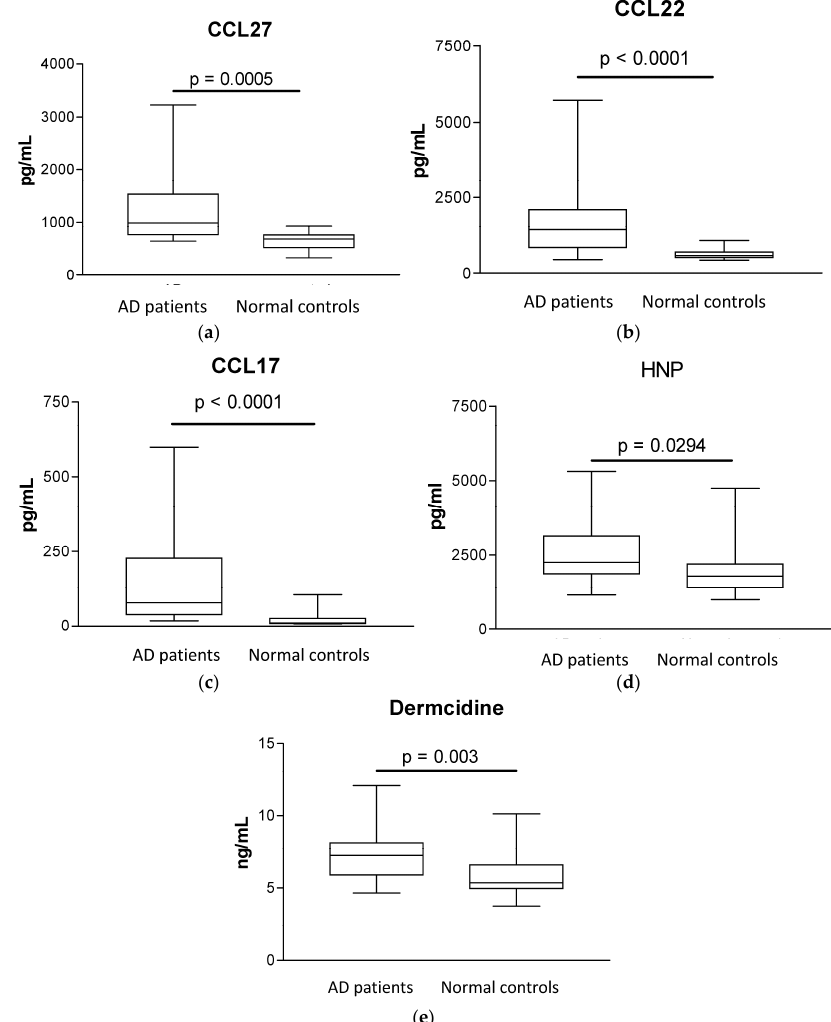
Figure 1. Plasma concentrations of CCL27, CCL22, CCL17, HNP and dermcidin in AD patients and normal controls. Box and whiskers plots showing comparisons of plasma concentrations of ( a ) CCL27; ( b ) CCL22; ( c ) CCL17; ( d ) HNP and ( e ) dermcidin between AD patients and control subjects were determined by Mann-Whitney rank sum